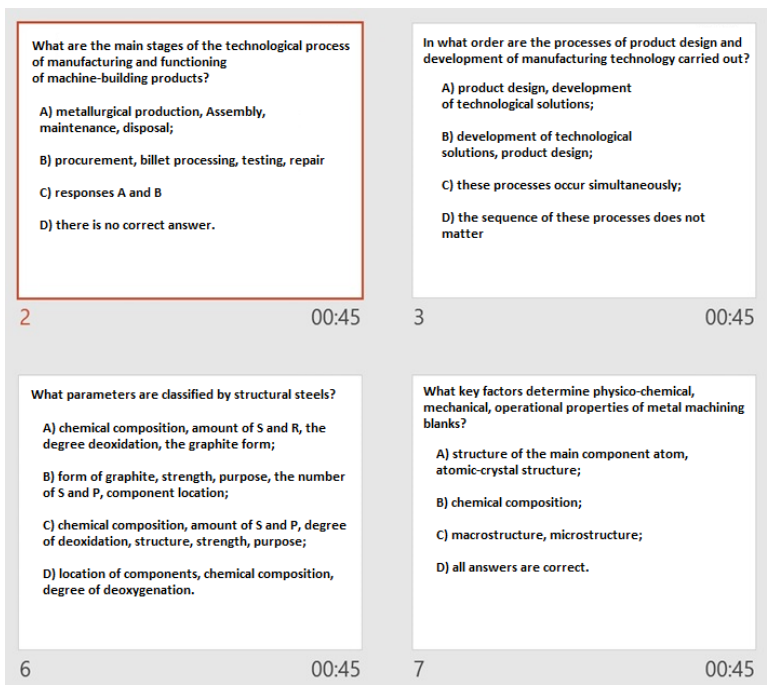
Fig. 1. Test case